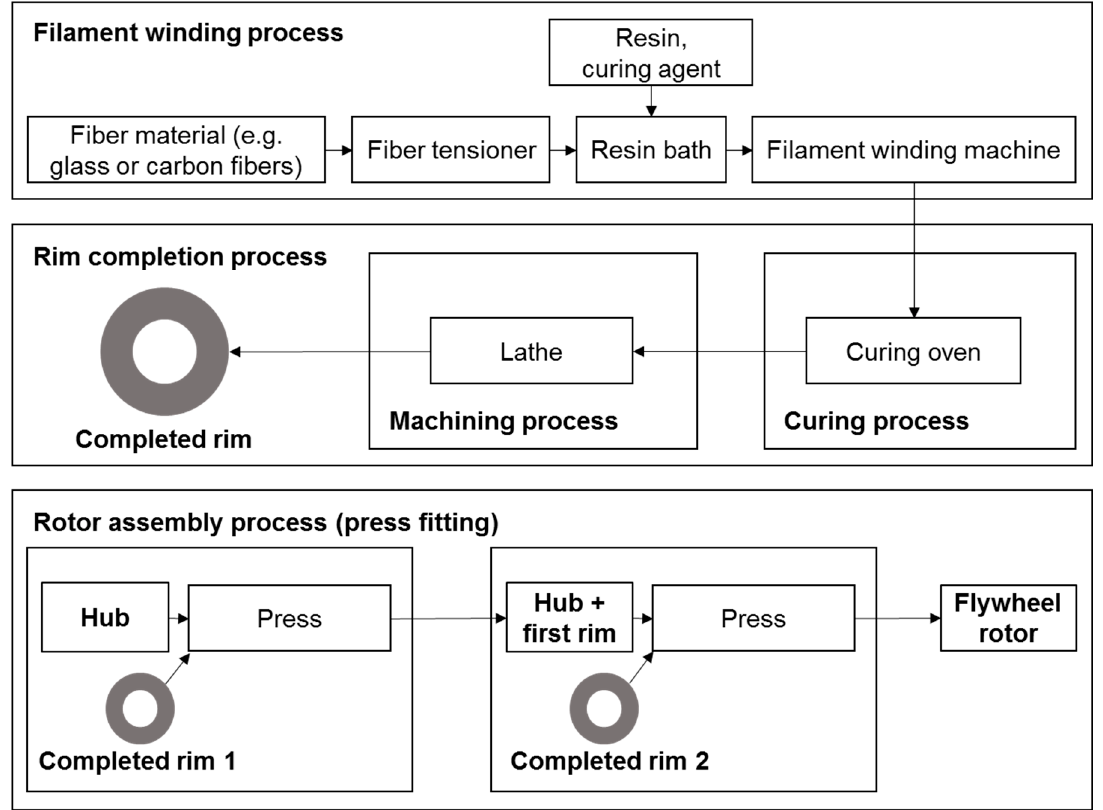
Figure 1. Manufacturing process of fiber composite FESS rotors.